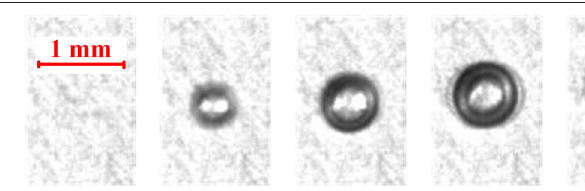
FIGURE 7 | Image sequence of bubble 1.